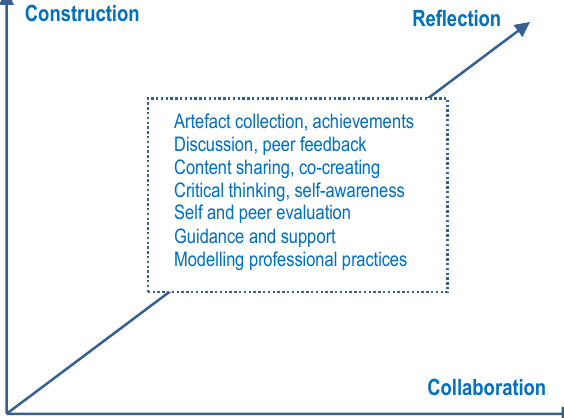
Figure 1. T he three dimensions of e-portfolio learning